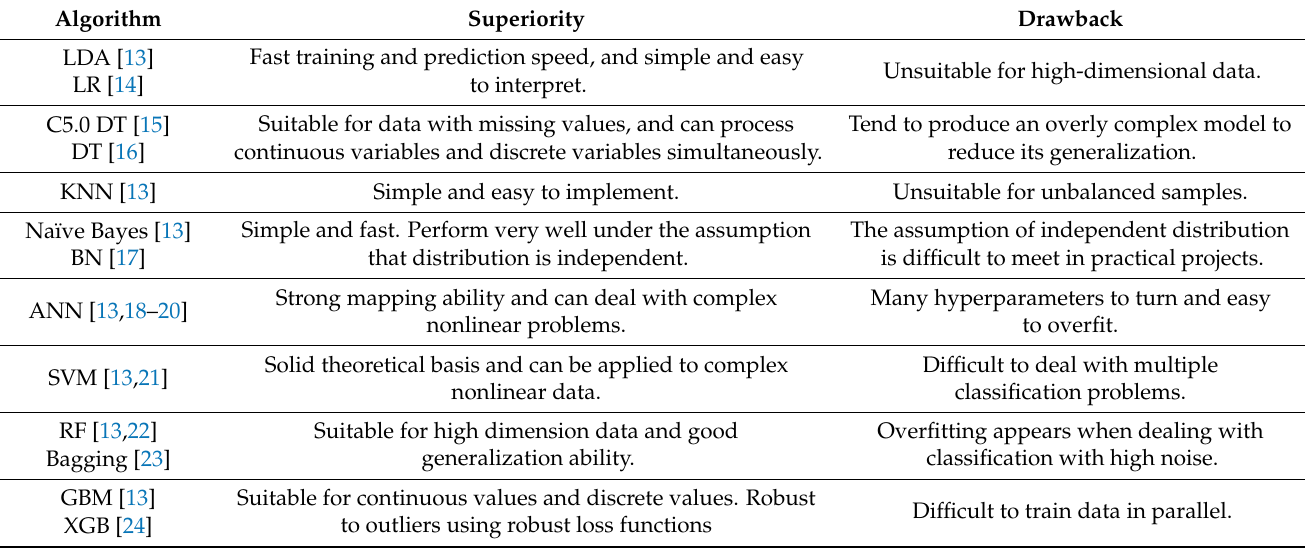
Table 1. The superiority and drawback of ML techniques for rockburst estimation